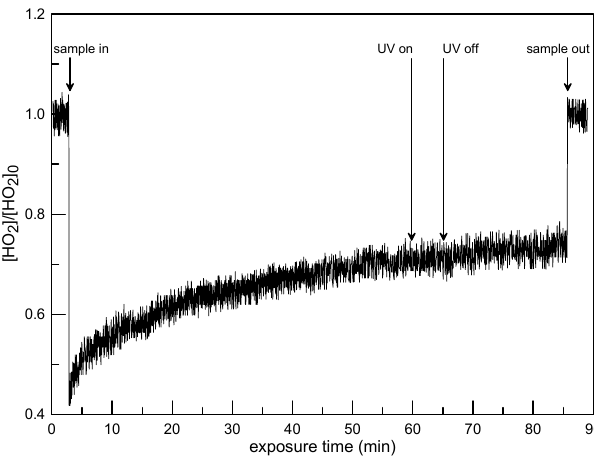
Fig. 2. Typical uptake profile of HO 2 on ATD surface: T = 300K, P = 1Torr, dry conditions (RH ≈ 0.02%), [HO 2 ] 0 = 1 . 3 × 10 12 moleculecm − 3 , sample mass = 0.47mgcm − 1 . HO 2 is moni- tored as HOBr + at m/z = 98 (see text).